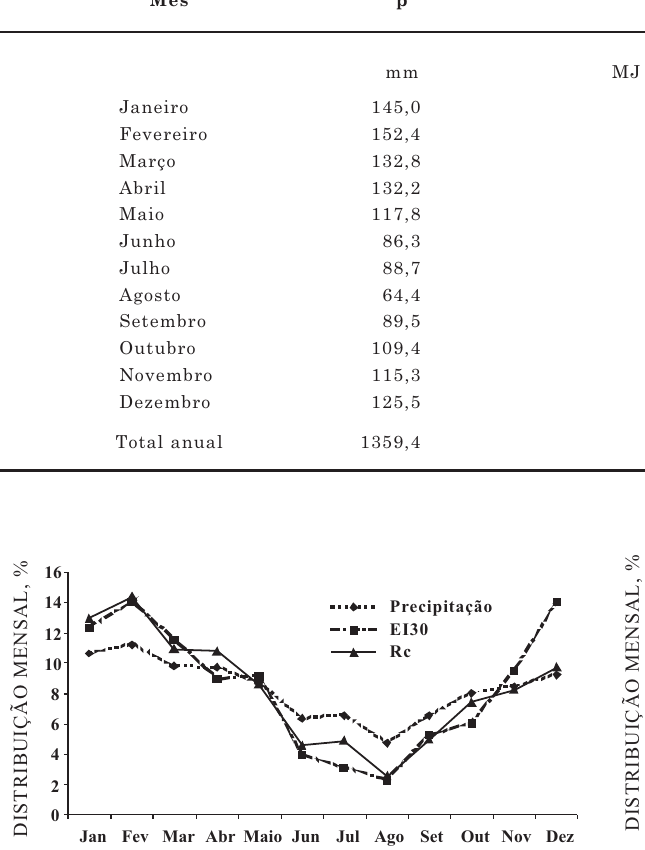
Figura 1. Distribuição percentual mensal da precipitação pluvial, índice EI chuva em Quaraí-RS, no período 1966-2003.